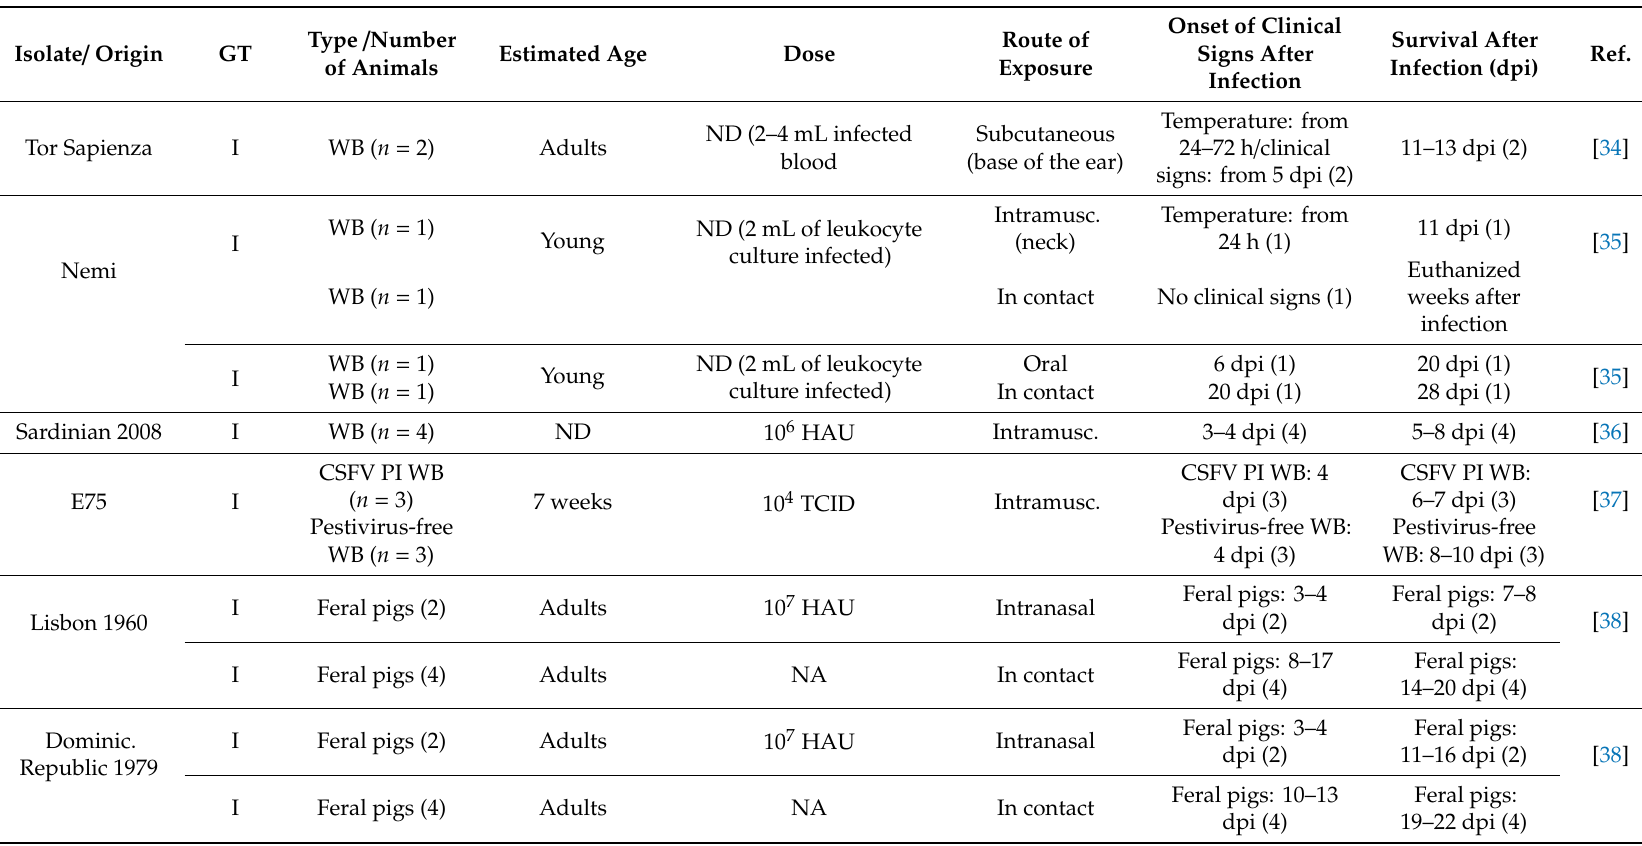
Table 2. Experimental infections of wild boar and feral pigs with ASFV Genotype I isolates. (GT): genotype; (WB): wild boar; (DP): domestic pigs; (HAU): haemagglutinating units; (TCID): Tissue Culture Infectious Dose (TCID), (ND): Not determined; (NA): Not administered (in contact animals). Isolate / Origin